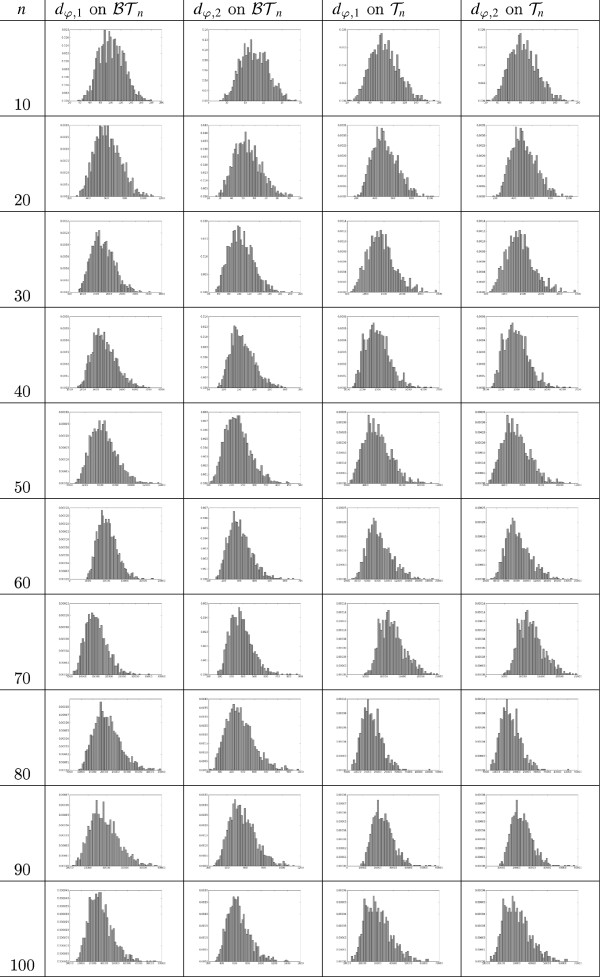
Histograms of the distributions of dφ,1 and dφ,2 onTnandBTnforn=10,20,…,100.